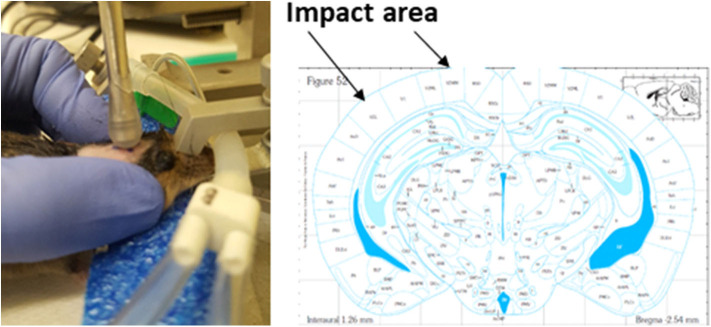
Demonstration of brain impact setting and brain area of injured.